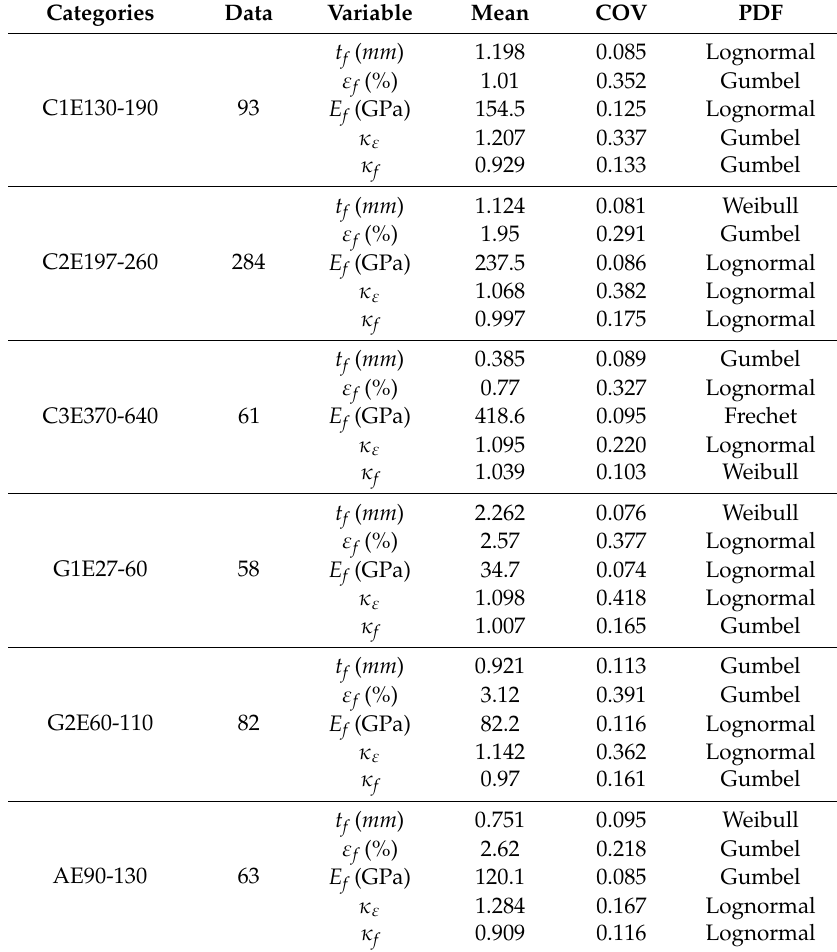
Table 4. Statistics of model error and fiber material properties of di ff erent segments of the current database of FRP-confined